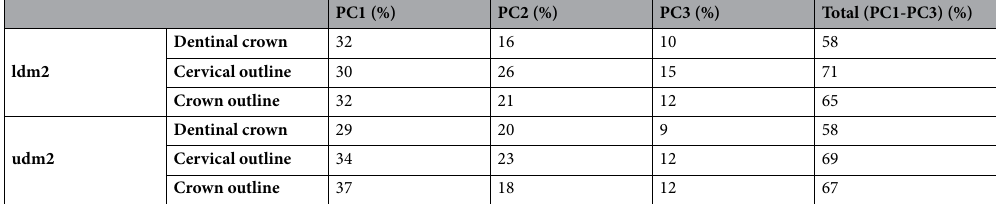
Table 2. Percentage of variance explained by the first three PCs as resulting from the analysis of the deciduous upper and lower second molars’ (udm2s and ldm2s, respectively) cervical outline, crown outline and combined enameldentine junction and cervical outline (dentinal crown).